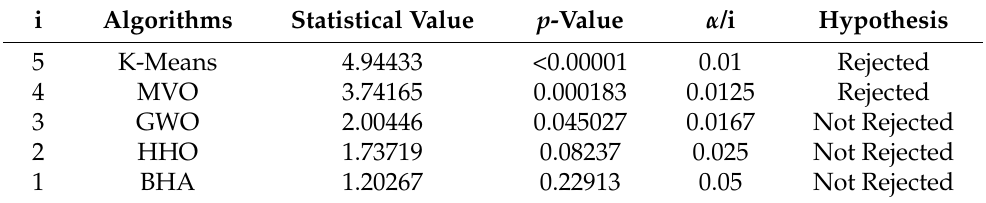
Table 8. Holm’s test statistical results based on mean of objective values for Shape datasets.